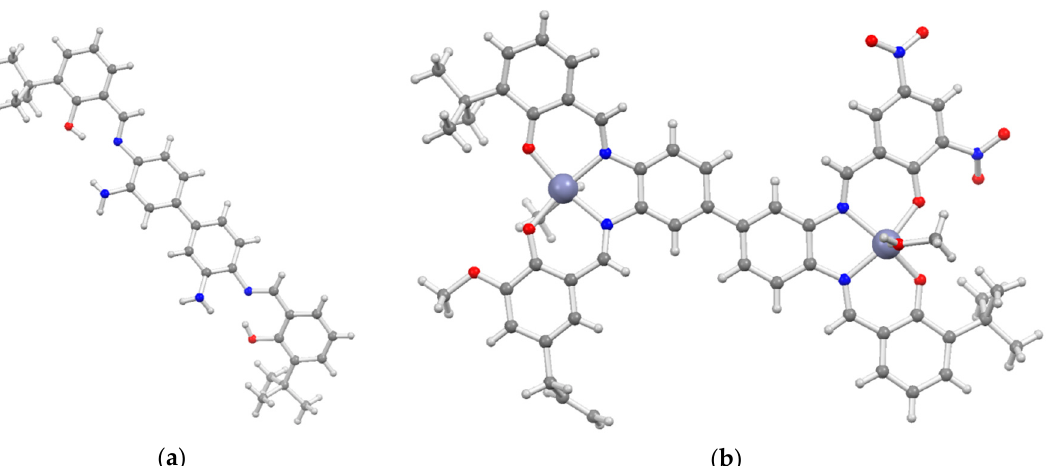
Figure 9. X-ray molecular structures of ( a ) the diamine derivative A from bis -1,2-phen and 3- t Bu-salH, CSD/CCDC JIPZUE/665961 [137], and ( b ) fully unsymmetrically substituted zinc(II) complex B (X = OMe, Y = allyl) with two additional axially-coordinated methanol molecules, CSD/CCDC AHO/FUZ724953 [139]. Reproduction of the structures with Mercury ® 4.3.1 software [71], color code: Zn = violet, O = red, N = blue, C = gray, H = white.